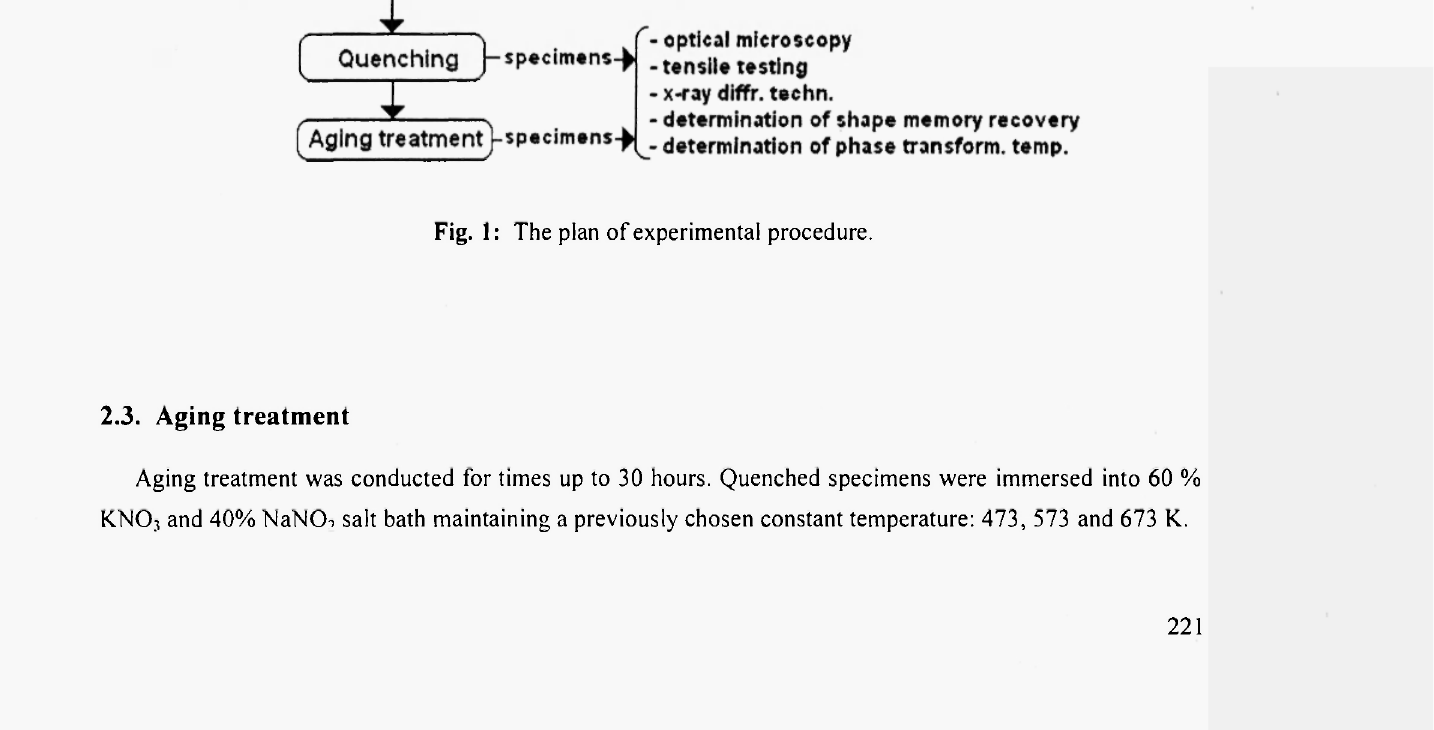
Fig. 1 : The plan of experimental